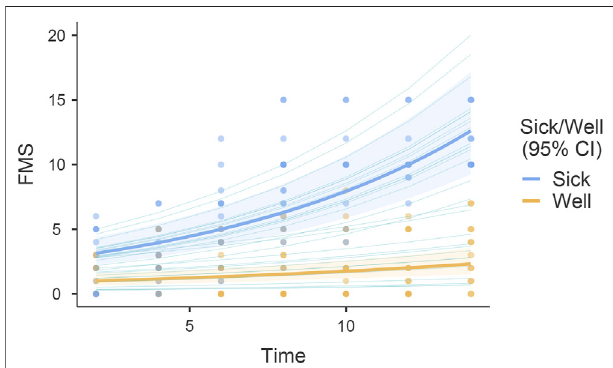
FIGURE 9 | Shows cybersickness severity (FMS) as a function of time in trial (Time) and participant Sick/Well grouping.